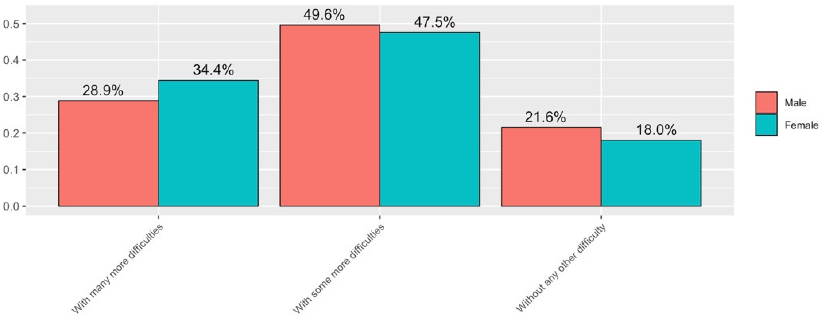
Figure 14. Answers to Q3 disaggregated by gender.